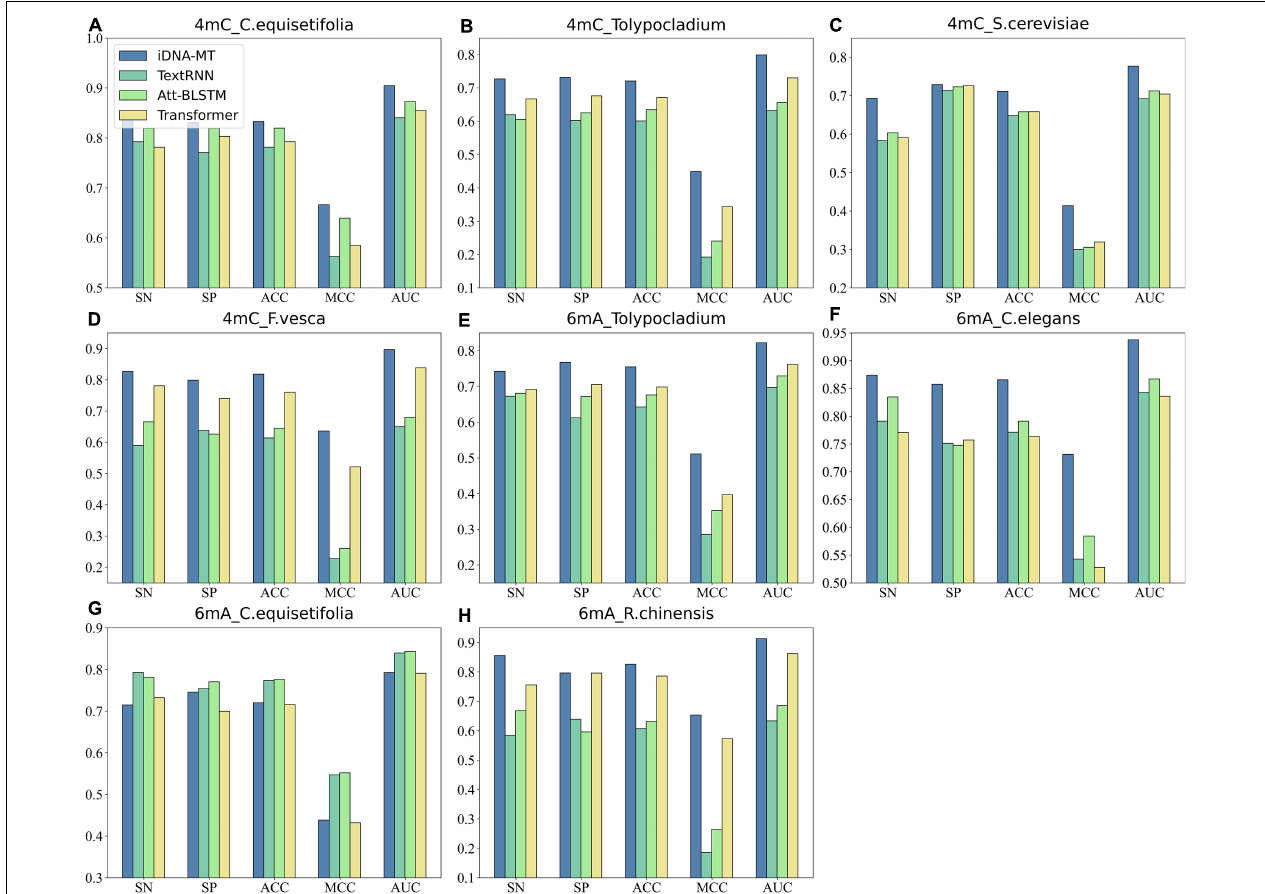
FIGURE 4 | Performance evaluation of iDNA-MT and other methods using different typical text classification methods in sharing module (A–D) represent the performance of iDNA-MT and other methods for identifying 4mC site. (E–H) represent the performance of iDNA-MT and other methods for identifying 6mA site.